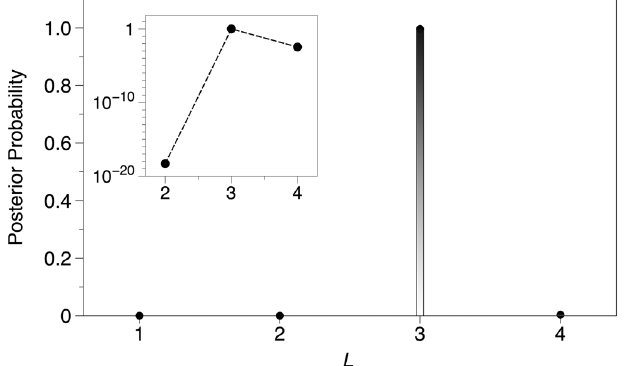
FIG. 3. Posterior probability P ð L jf X ð t Þg N Þ as a function of t ¼ 1 the number of layers L , computed from a trajectory of 2 × 10 4 time steps generated using a model with L ¼ 3 cycle graphs 1 − r ¼ 0 . 84 for i ¼ 1 , 2, 3, ( K ¼ 3 ) and parameters R ii ¼ 1 Þ 0 . 16 , T ð 2 Þ 0 . 76 , and T ð 3 Þ 0 . 24 (see the text T ð α ; α þ 1 ¼ α ; α þ 1 ¼ α ; α þ 1 ¼ and Appendix B for details). The algorithm easily estimates